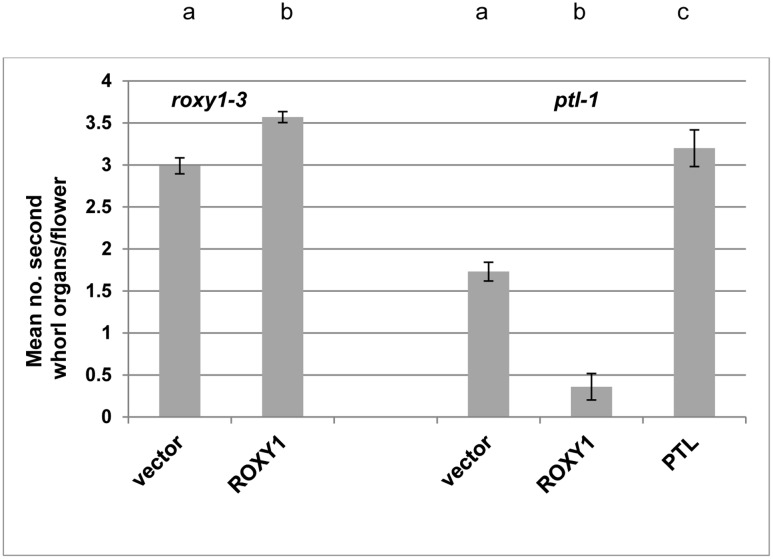
Effect of ectopically expressing ROXY1 in the PTL expression zone on second whorl organ development. Mean number of second whorl organs per flower in roxy1-3 (left) or ptl-1 (right) T1 plants transformed with ROXY1 or PTL under the control of the PTL promoter region and downstream of a GUS-encoding sequence flanked by self-cleavage peptide sequences 2A that upon translation result in excision of both GUS and the downstream protein [pPTL(1.3i):2A-GUS-2A]. Negative controls involved T1 plants transformed with the empty vector, and positive controls involved roxy-1 plants transformed with ROXY1, and ptl-1 plants transformed with PTL. Individual data for the 8–15 T1 plants scored for each treatment are provided in Supplementary Figure S2. Bars represent SEM. Pairwise comparisons by t-tests were carried out. All comparisons were significantly different (p < 0.01) as indicated by the different letters at the top of each column for the roxy1-3 transformants (left), and independently for the ptl-1 transformants (right).